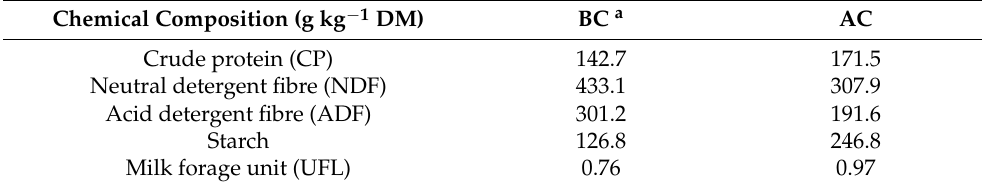
Table 1. Chemical composition of the TMR fed to the heifers during the present